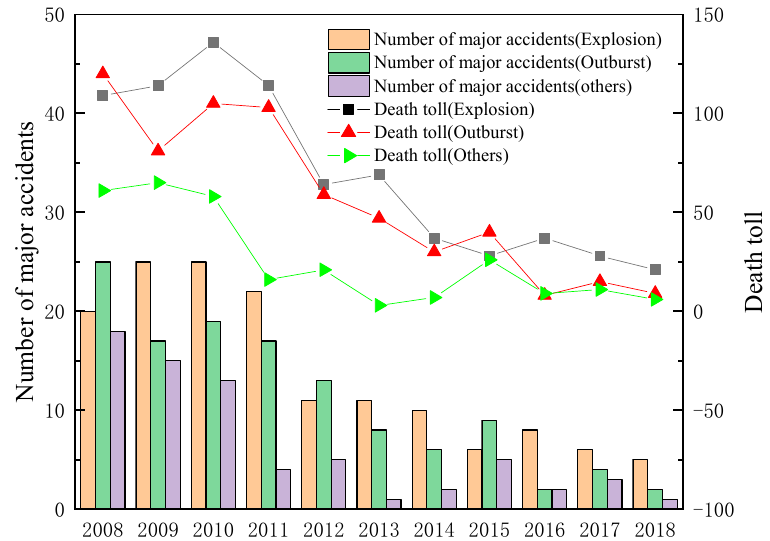
Figure 10. Variations of the different types of accidents in major gas accidents from 2008 to